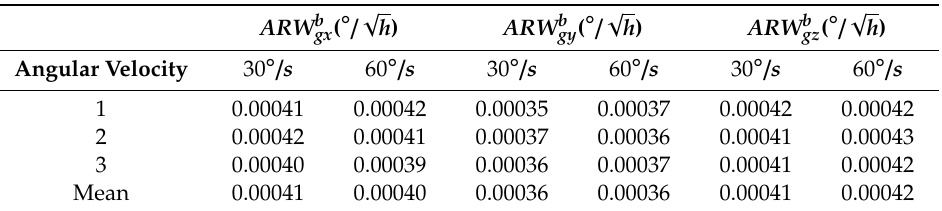
Table 5. Experiment results in rate-biased mode.